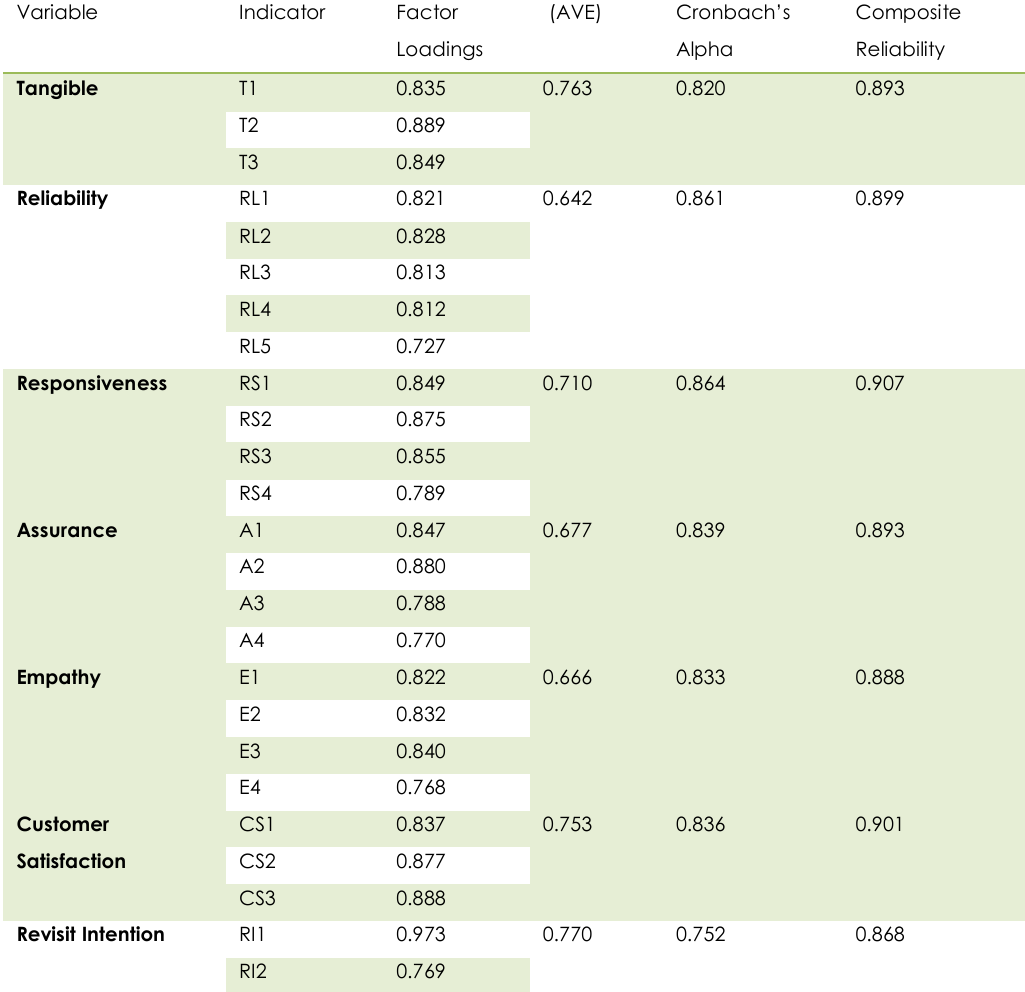
Table 3 Model Validity and Reliability